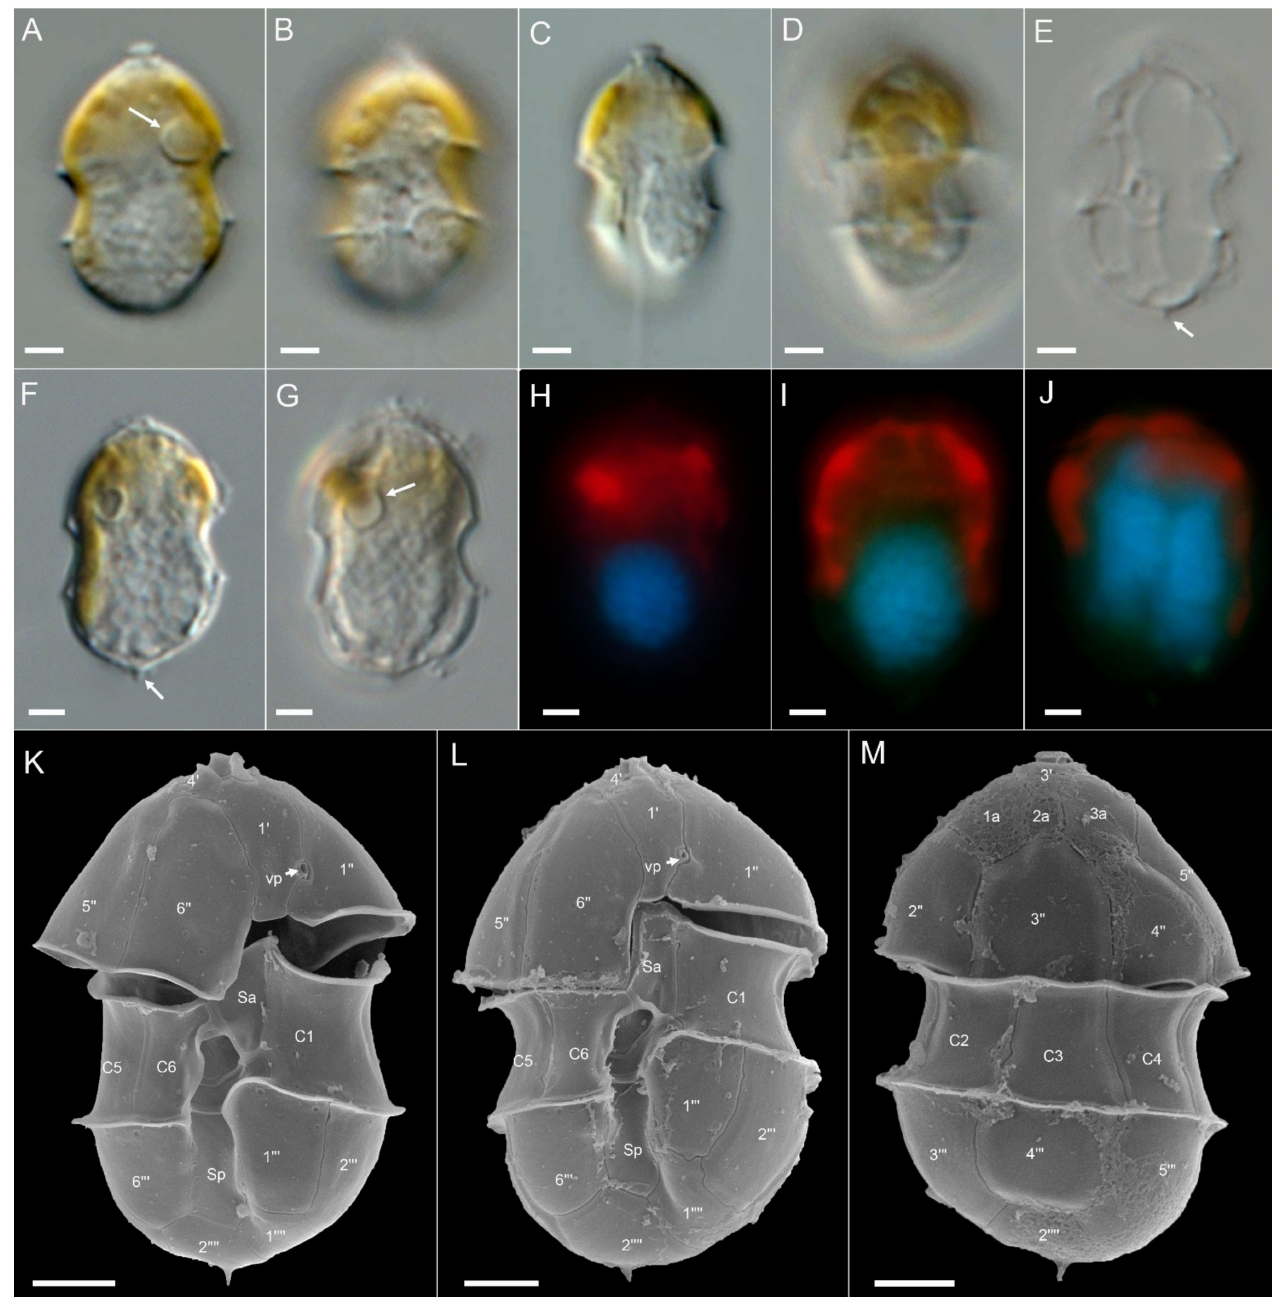
Figure 6. Azadinium cf. spinosum strain 5-B9. ( A – G ) LM images of living ( A – D ) or formalin fixed ( E – G ) cells to indicate general size and shape. Note the distinct pyrenoid in the episome (arrow in A , G ) and the antapical spine (arrow in E , F ). ( H – J ) Formalin fixed and DAPI-stained cells viewed with UV excitation to indicate shape and position of the nucleus. ( J ) Late stage of nuclear division. Note the elongated shape of the nucleus. ( K – M ) SEM images of different thecae in ventral ( K , L ) or dorsal ( M ) view. Note position of ventral po—-re (vp). Plate labels according to the Kofoidian system. Abbreviation of sulcal plates: Sa = anterior sulcal plate; Sp = posterior sulcal plate. Scale bars = 2 µ